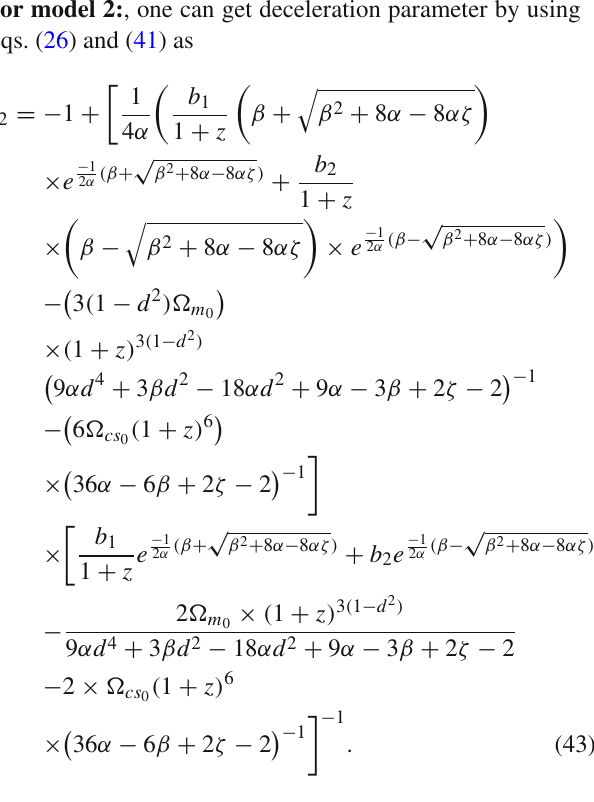
Fig. 4 Plot of deceleration parameter q 1 , q 2 and q 3 versus redshift z